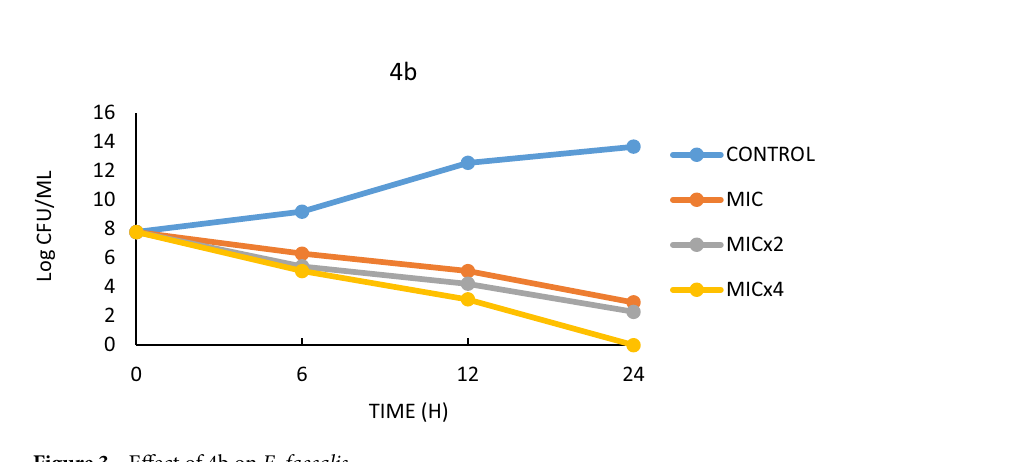
Figure 3. Effect of 4b on E.